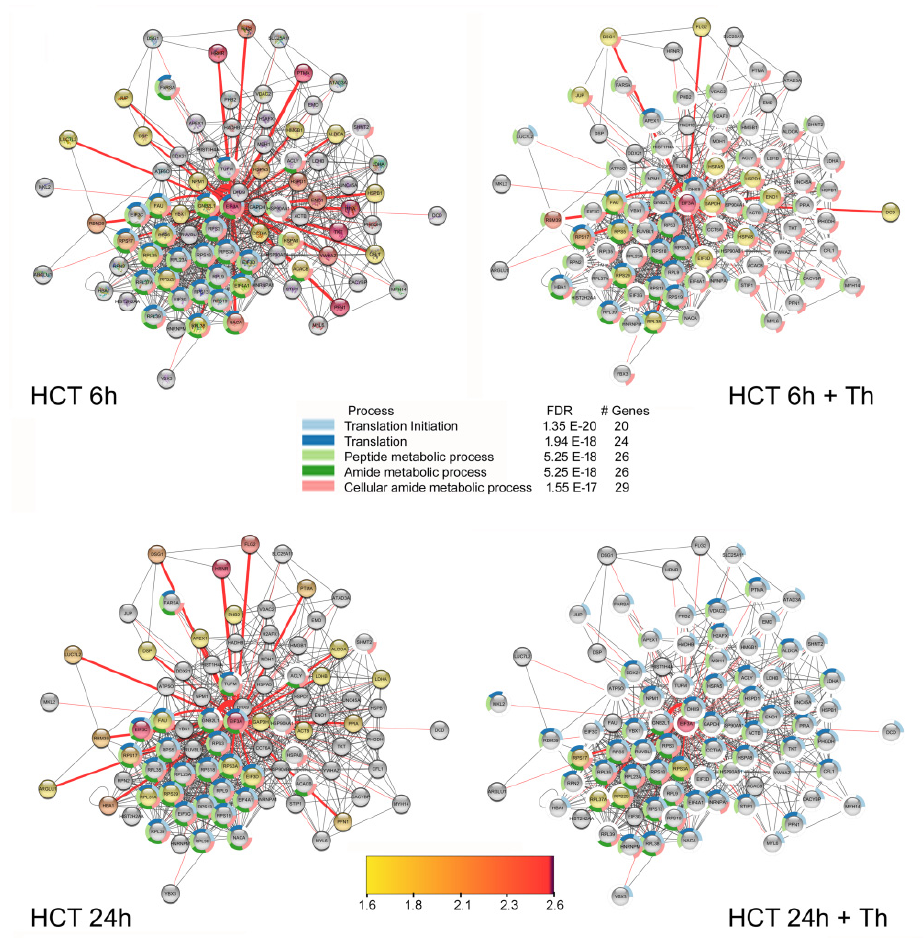
Figure 5. Visualization of the eIF3A-dependent biotinylation ratios by cytoscape [43] for the cell lines HEK-293T (HEK) and HCT-116 (HCT) under all experimental conditions incorporating interactions from the string database [44]. For this visualization, all proteins were included exhibiting a biotiny- lation ratio higher than 1.5 in at least one condition. The color of the protein nodes corresponds to the biotinylation ratios according to the color gradient from yellow to purple as shown in the figure. For grey nodes, the ratio is smaller than 1.5. Red lines indicate interactions determined in this study; black lines indicate interactions taken from the string database. The width of the red lines corresponds to the biotinylation ratio. FDR: false discovery rate. The result of the GO-term enrichment analysis for the cellular component, molecular function and biological process and for the databases KEGG pathway [45] and Reactome [46] is also